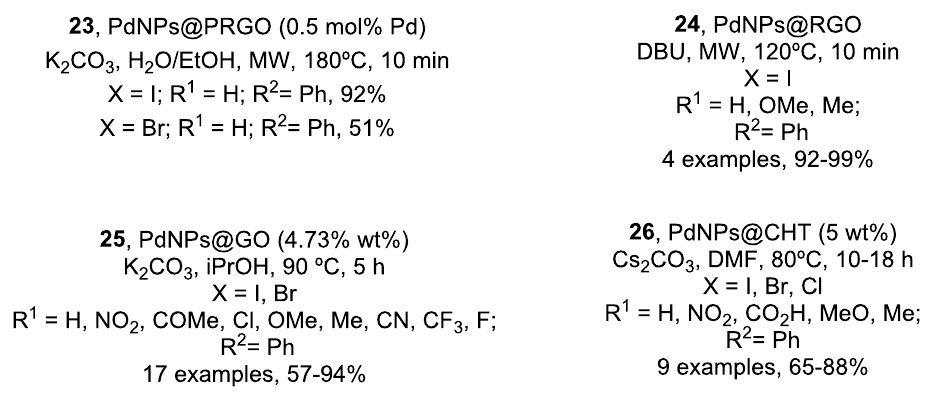
Figure 9. PdNPs supported on carbonaceous catalyzing the Sonogashira coupling. Conditions, substrate scope and yield range (Scheme 2).